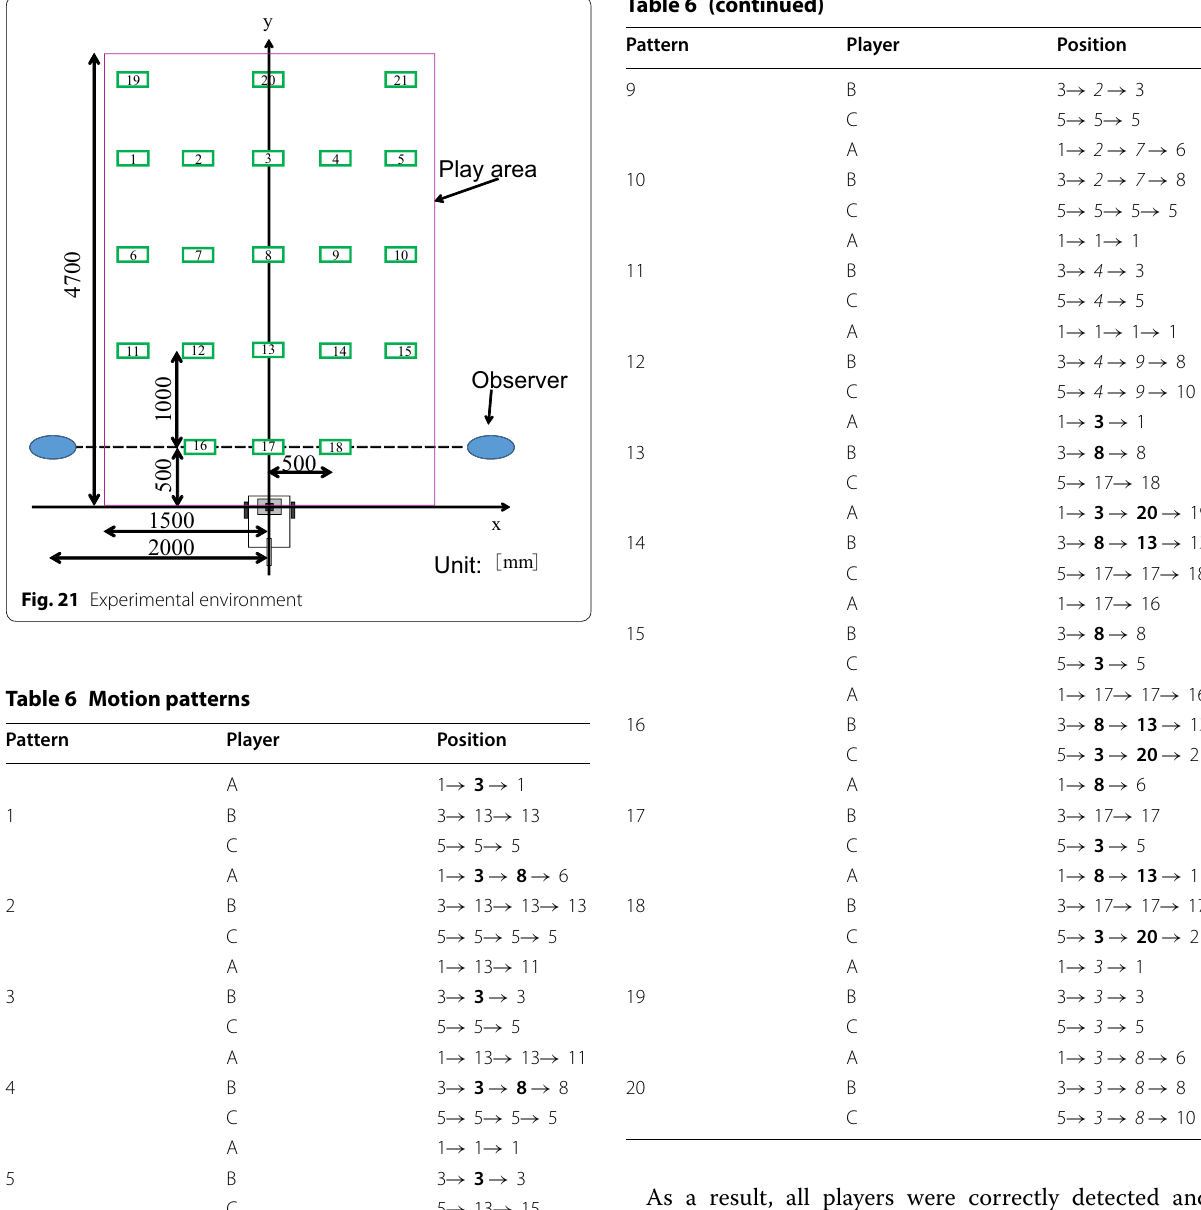
As a result, all players were correctly detected and tracked at the final position of all patterns. As examples, images of the players, as well as screenshots of the player detection system for patterns 8 and 20 are shown in Figs. 22 and 23, respectively.The video clips of those two motions are provided as Additional files 1 and 2. In Fig. 22, player B moved forward, and player C moved behind player B (Fig. 22b, c). At this time, the system lost player C, which can be confirmed in Fig. 22f in which only the center point (the pink circle) is displayed in the green rectangle and the body was not detected. As player C stepped aside (Fig. 22h, i), the system found player C and tracked him again (Fig.